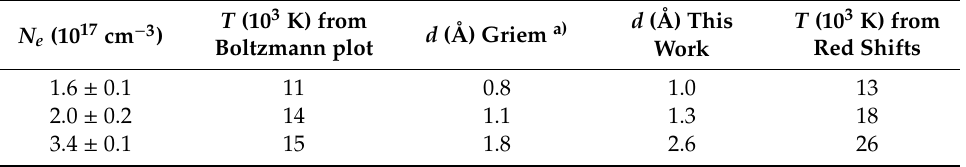
Table 5. Electronic temperatures obtained from Boltzmann plot compared with the temperatures estimated from red shifts of the H α -line obtained in this work at 5, 3, and 2 µ s delay times and 500 ns of time